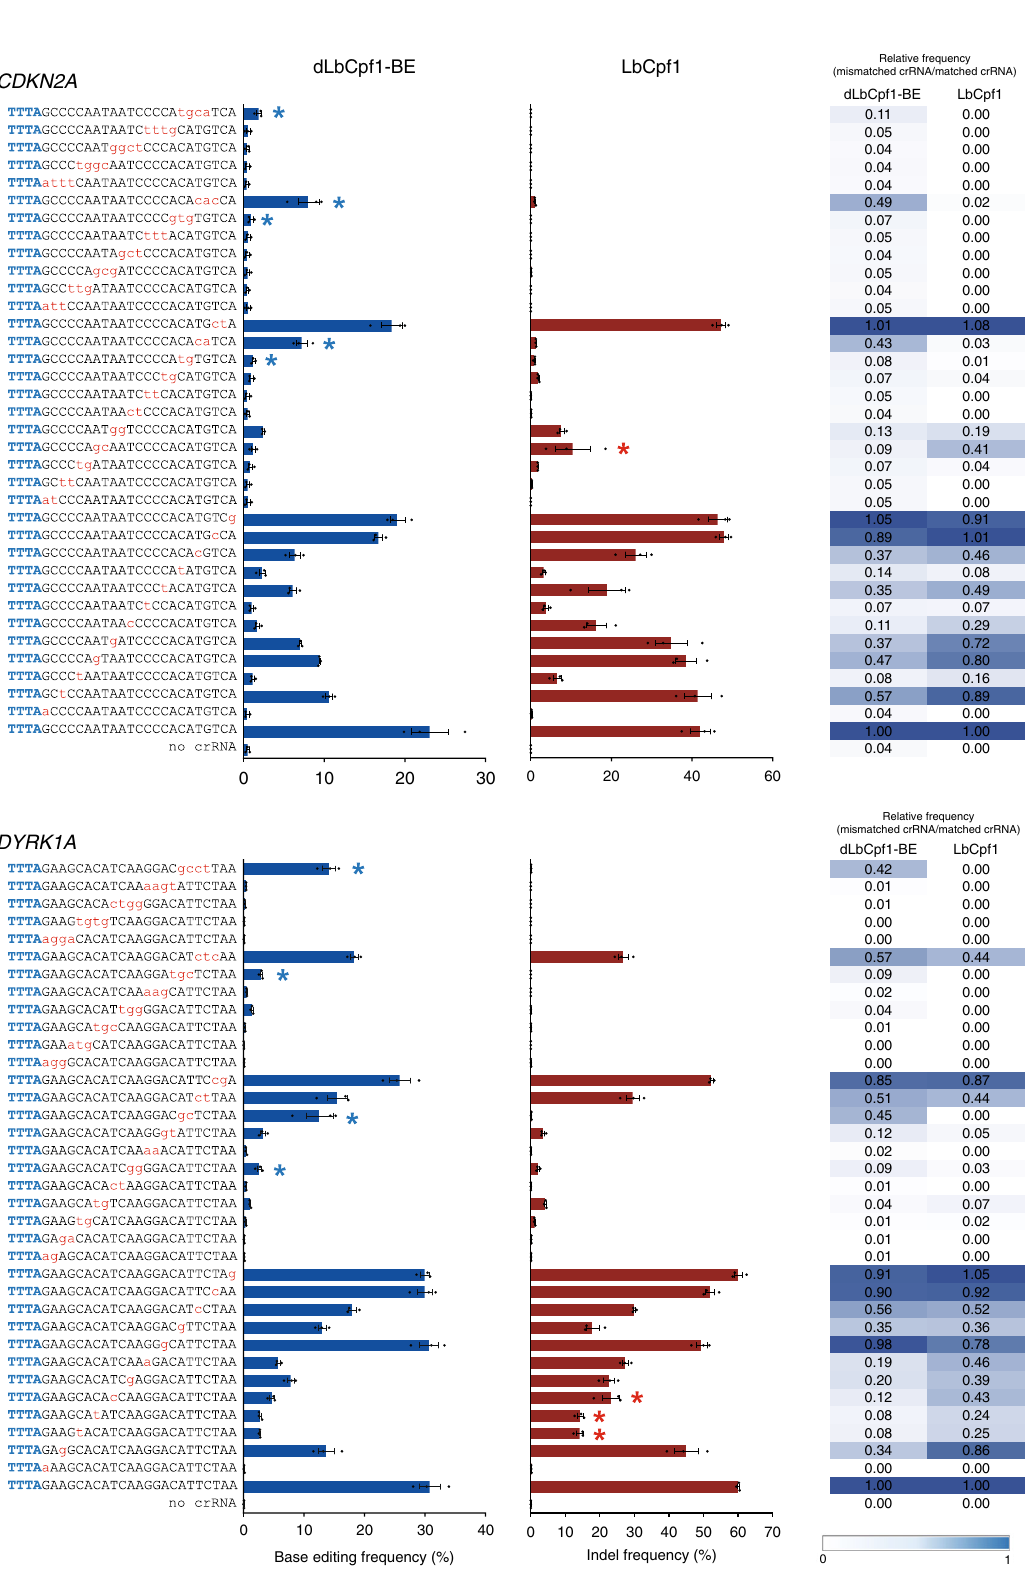
Digenome-seq that satis fi ed the following requirements: (i) the count of sequence reads with the same 5 ′ end was greater than 5 and at least 20% of the sequence reads exhibited a straight alignment at a given position and (ii) that contained a PAM sequence (5 ′ -TTTN-3 ′ ) and had 8 or fewer mismatches with the target sequence or contained PAM-like sequences (5 ′ -NTTN-3 ′ ,